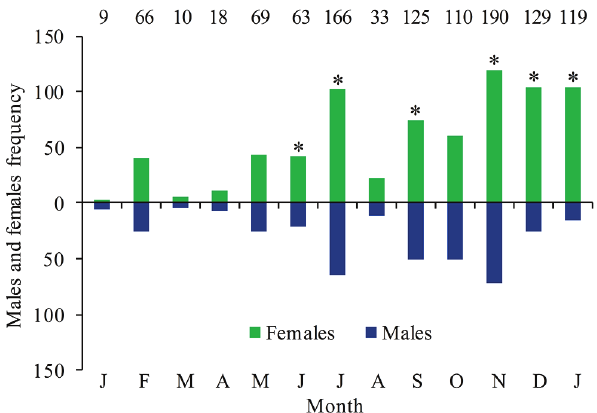
Fig. 2. Monthly distribution of Genidens genidens males and females in Guanabara Bay, Rio de Janeiro, Brazil from January 2014 to January 2015. The values at the top indicate the number of individuals caught each month. (*) Signifi- cant difference ( p